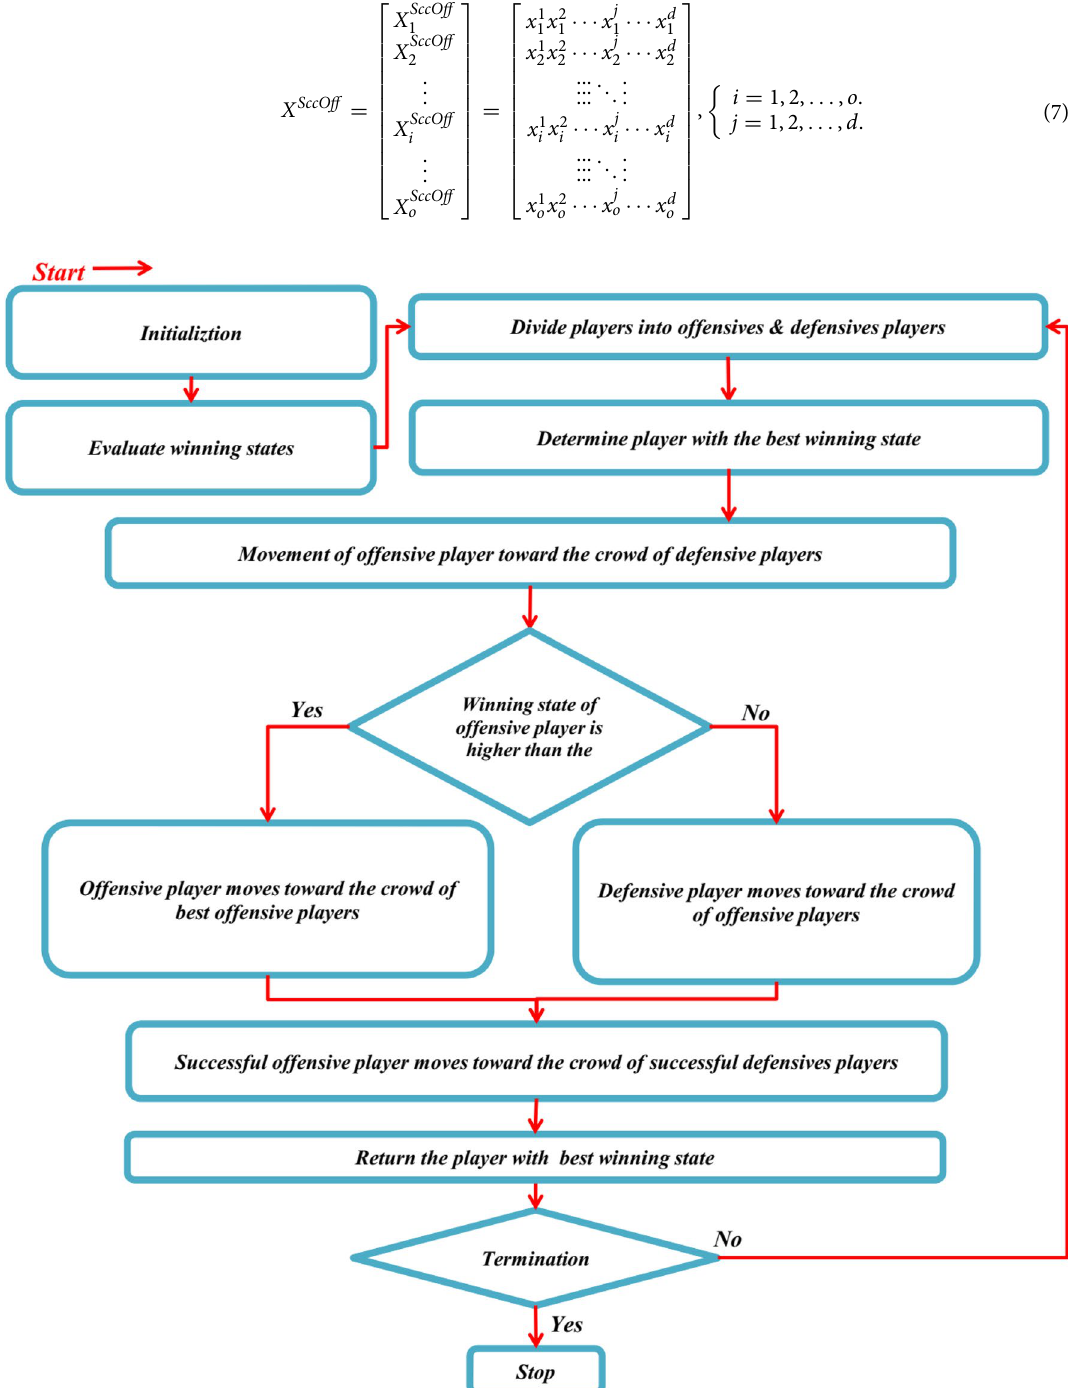
Figure 2. Flowchart of the